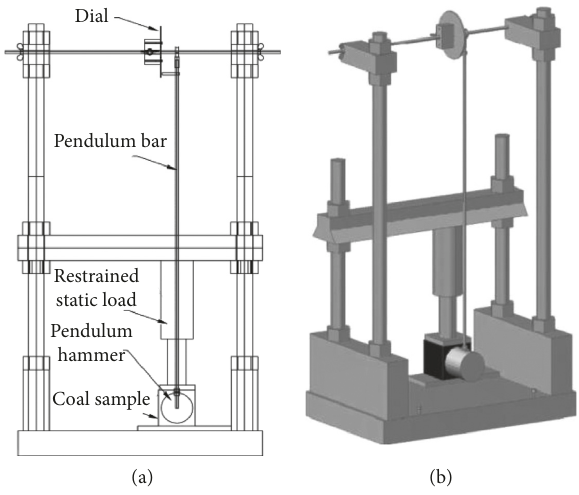
Figure 2: Pendulum impact loading test device with unidirectional restraint.